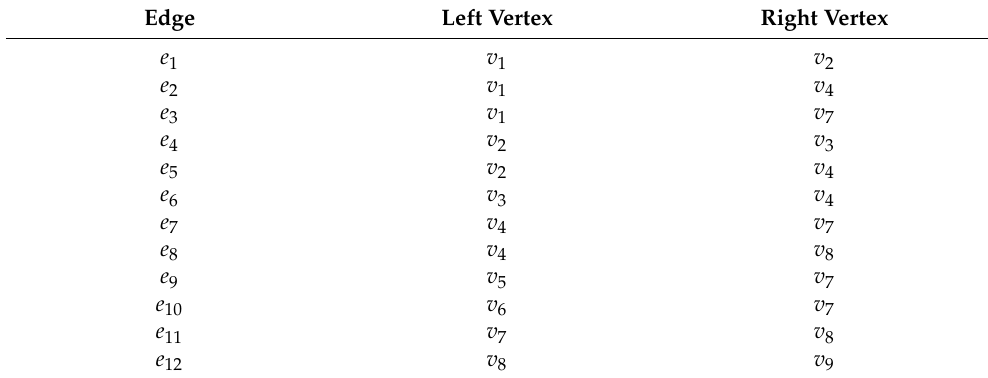
Table A2. List of vertices.